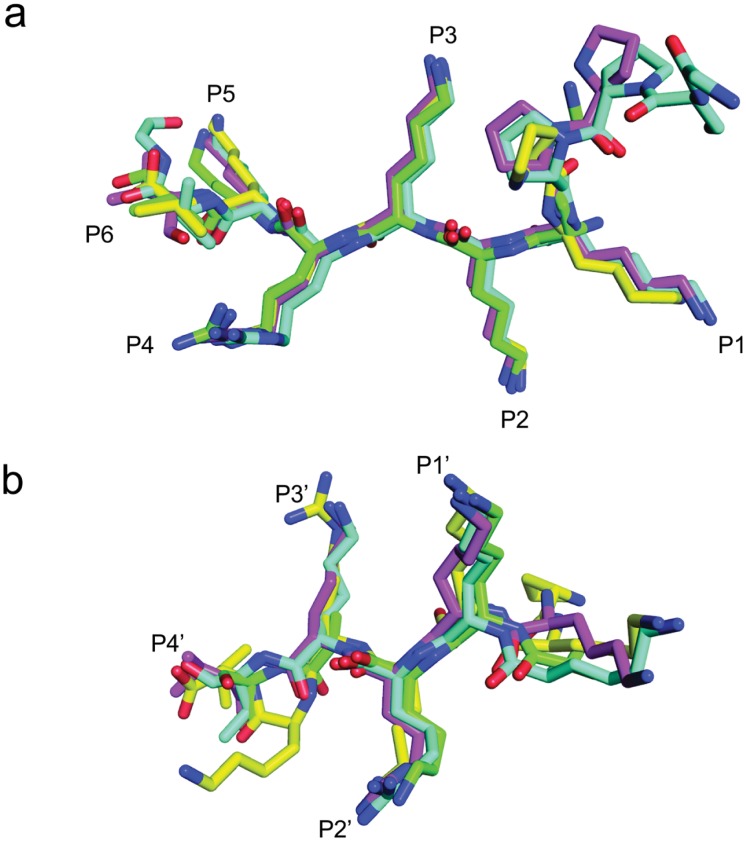
Comparison of SV40NLS peptides binding to the major (a) and minor (b) binding sites for Impα structures from different organisms.SV40NLS peptides in complex with NcImpα (magenta), ScImpα (green), OsImpα (blue) and MmImpα (yellow) were superimposed using the Cα atoms of the peptides. Positions binding corresponding to the major (P1-P5) and minor (P1′-P4′) sites are identified along the chains (binding pocket labels were based on peptide binding with NcImpα).